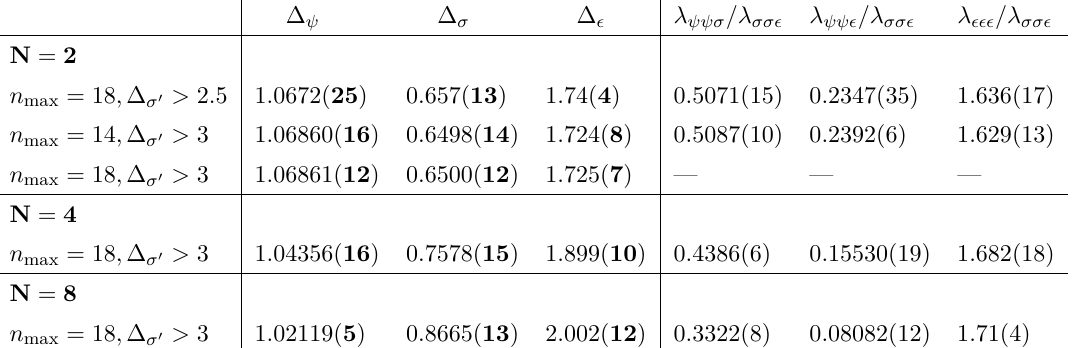
Table 5 . A summary of the results of this work with estimates of all six search parameters, compiled here for the reader’s convenience. We do not report the n = 18 OPE coefficient ratio estimates, max as we did not have sufficient statistics. Note that we have reported the scaling dimension estimates as only scaling dimensions, and we have only included this work’s results. For critical exponents and comparisons, see table 1.